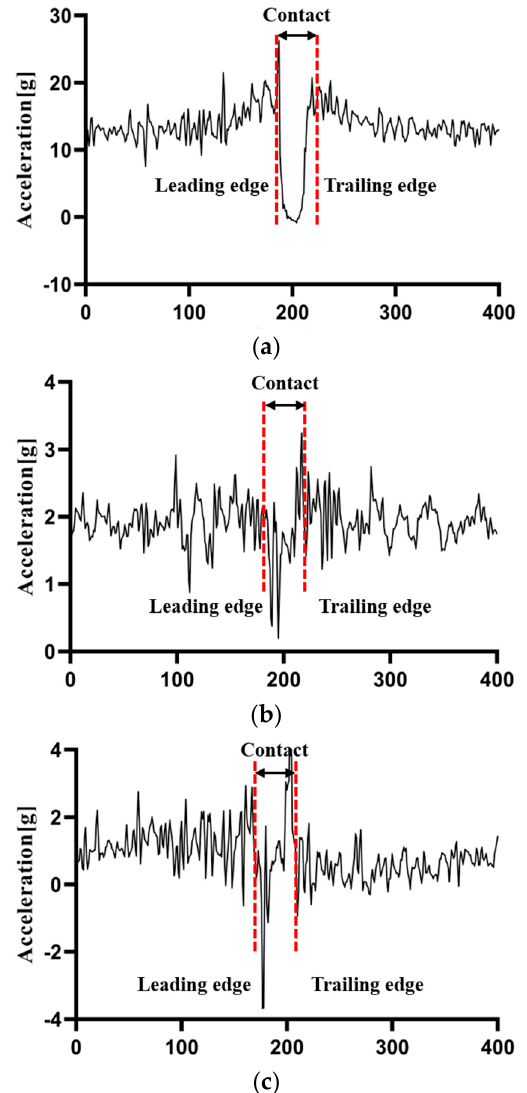
Figure 5. Example acceleration signal under the dry road condition: ( a ) x ‐ axis acceleration signal, ( b ) y ‐ axis acceleration signal, and ( c ) z ‐ axis acceleration signal.